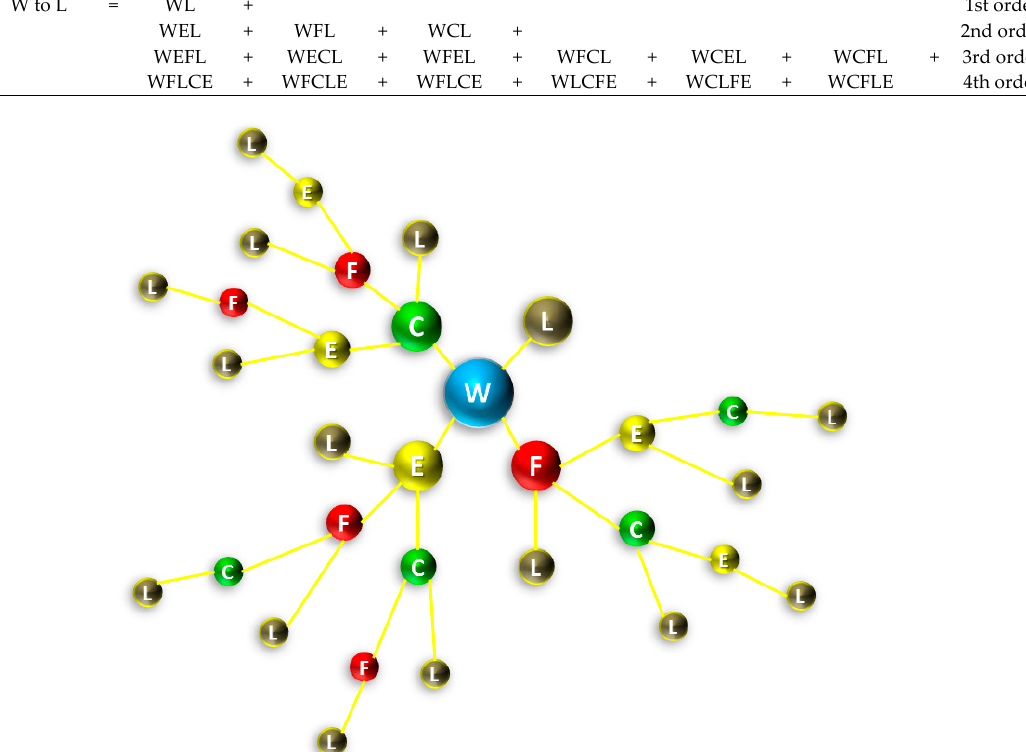
Figure 3. Nexus tree for water to land use, showing the formation of all 16 direct and indirect pathways by which a change in water can bring about a change in land use. Color representation for nexus tree nodes are as follows: Water = blue; Energy = yellow; Food = red; Land = brown; Climate = green.